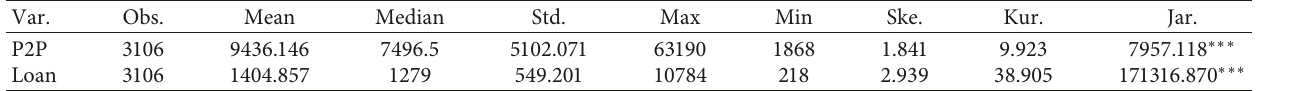
Table 1: Statistics of searching